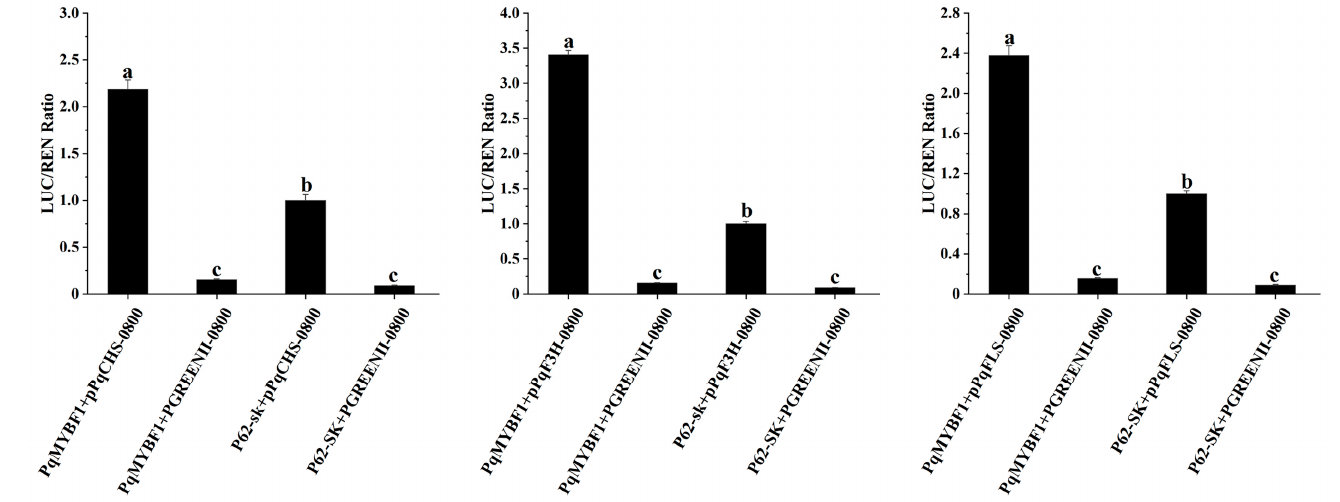
Figure 7. PqMYBF1 interacts with the flavonol-related synthesis gene in vivo. PqMYBF1 induced the expression of PqCHS , PqF3H , and PqFLS . The activities of promoters were indicated by the ratio of LUC/REN. Three independent experiments were performed for each sample. The data are shown as the means ±SDs. a, b, and c indicate significant differences at the p ≤ 0.05 level in the Duncan test.